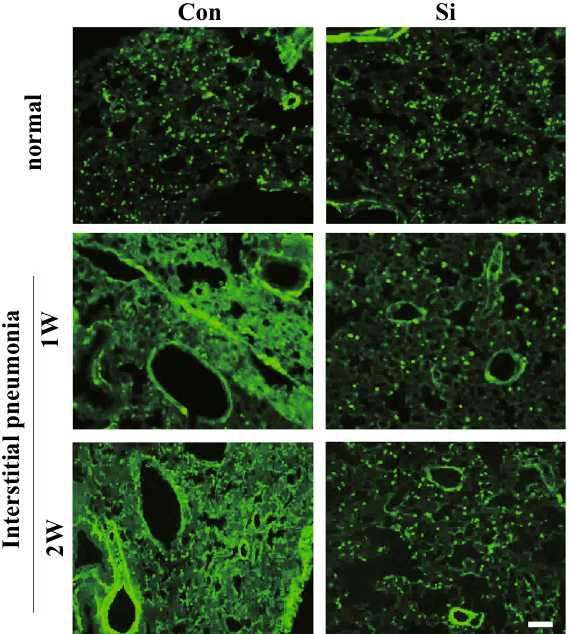
Figure 3. Immunofluorescence staining using α-SMA. The representative microphotographs of the lung in the normal mice (upper panel) and IP mouse models treated with MTX for 1 week (middle panel) and 2 weeks (bottom panel). Left panel: Con group or Con-IP group; right panel: Si group or Si-IP group. Scale bar: 20 µm.